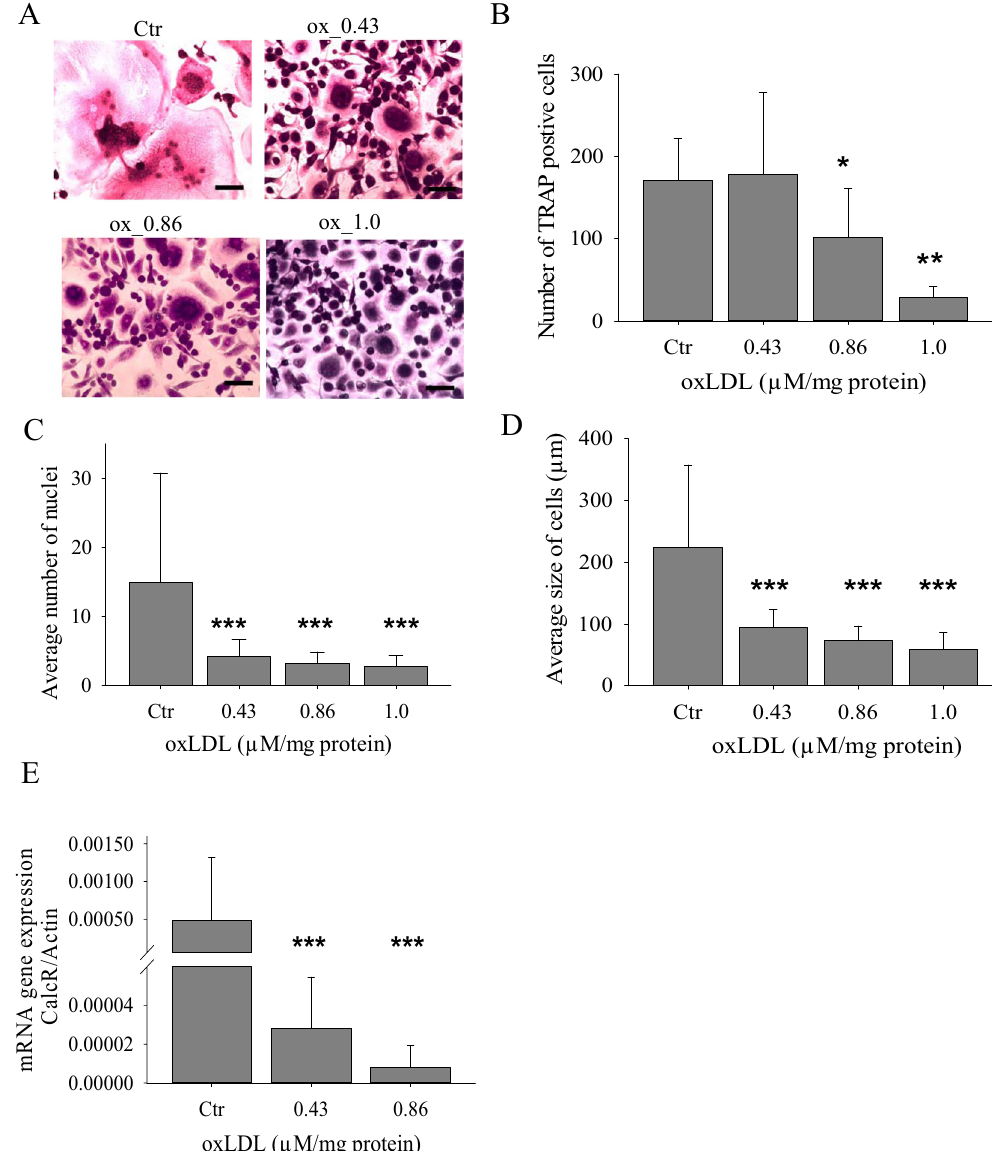
Figure 1. oxLDL inhibits fusion of mononuclear cells. Monocytes plated on glass coverslips were grown in the presence of M-CSF and RANKL for a total of 15 days, and then TRAP staining was carried out. ( A ) TRAP staining of control and oxLDL treated cells. ( B ) Quantification of the average number of TRAP positive cells. ( C ) Average number of nuclei per TRAP positive cell. ( D ) Quantification of the average size of TRAP positive cell. Magnification x25, scale bar 200 µ m. n ≥ 3 ( E ) mRNA expression of CalcR with and without